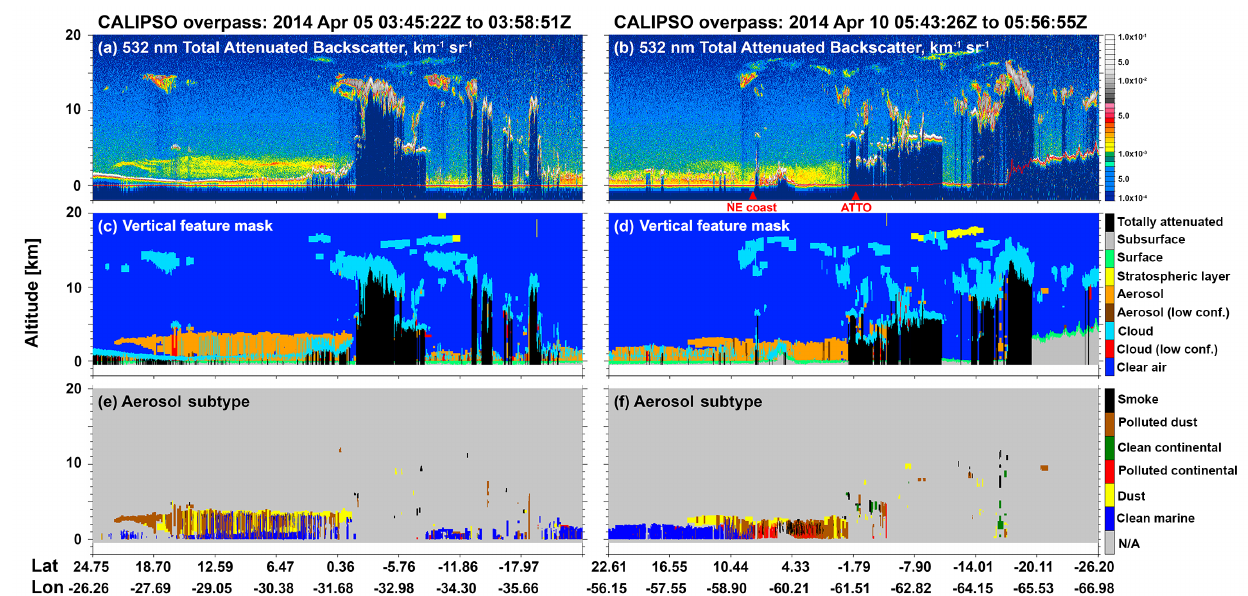
Figure 12. CALIOP lidar profiles of the African dust plume from 5 and 10 April 2014. The corresponding satellite orbits are shown as overlay with the MODIS AOD maps in Fig. 11. Red markers in panel (d) show position of the ATTO site and the northeast South American